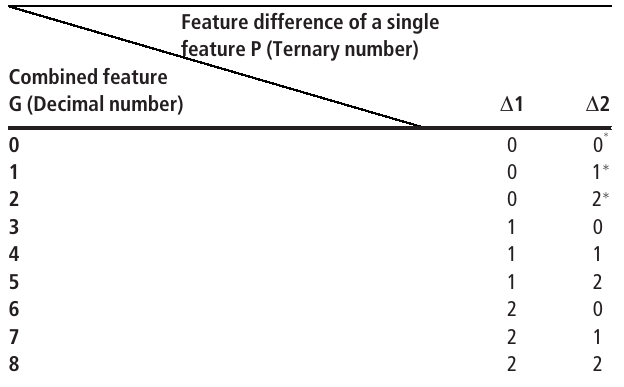
Figure 6 Error rate of strong classi fi er at 1-th curve